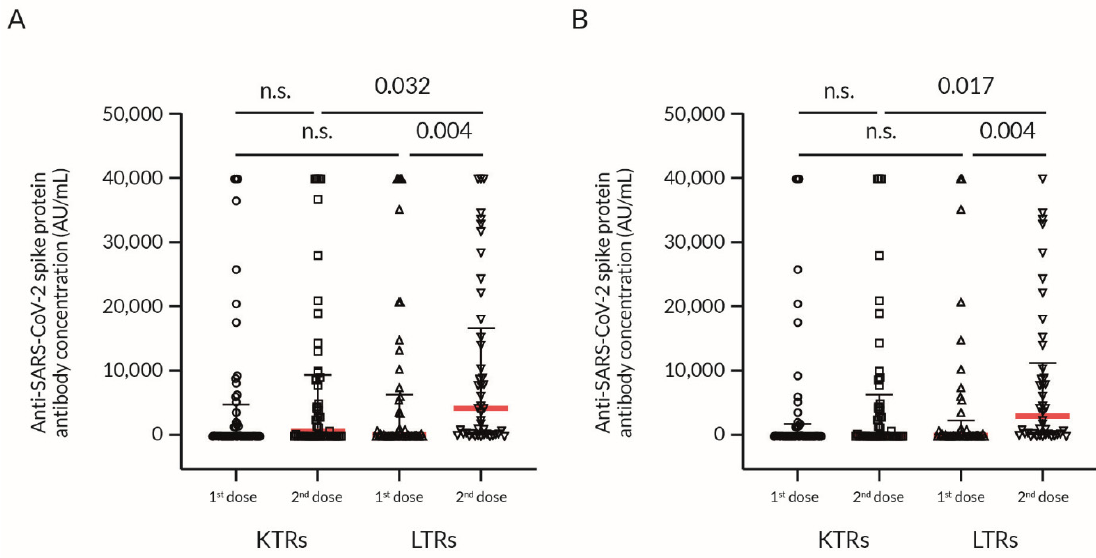
Figure 2. Anti-SARS-CoV-2 spike protein Ab production in response to BNT162b2 vaccination in KTRs and LTRs. Immune response to vaccination depending on the type of transplanted organ. Values are presented as the scatter-dot plot with median (middle line), lower (25%), and upper (75%) quartile (as whiskers); the p -value was calculated with the non- parametric Mann–Whitney U Test. ( A ) All patients including positive history of COVID-19 infection (confirmed by PCR test), ( B ) patients without confirmed COVID-19 infection. 1st dose = 4–6 weeks after the first dose of vaccination; 2nd dose = 4–8 weeks after the second dose of vaccination; BNT162b2 = BioNTech/Pfizer COVID-19 mRNA vaccine; KTRs = kidney transplant recipients; LTRs = liver transplant recipients; n.s. = not